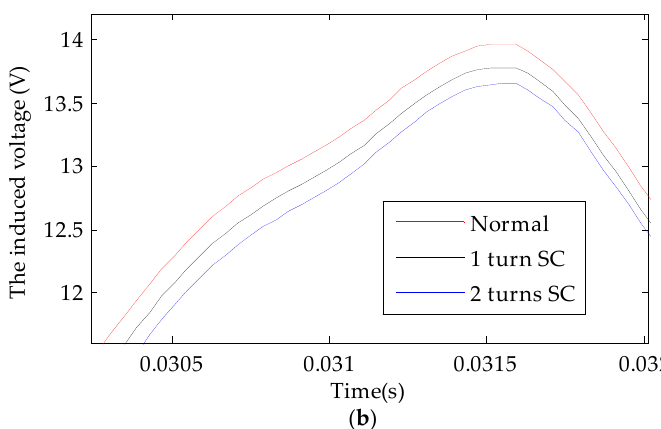
Figure 7. Induced voltage curve for the No. 1 detection coil with different short circuit degrees in slot #3 under rated load conditions: ( a ) global map; ( b ) local map.